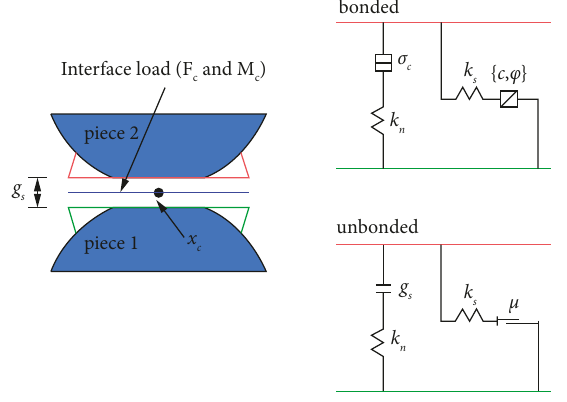
Figure 1: Smooth joint model